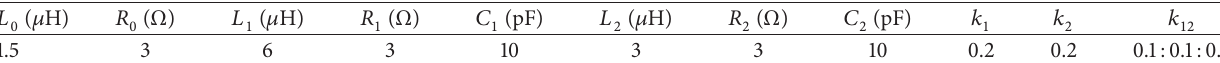
Table 6: Change in 𝑘 12 .